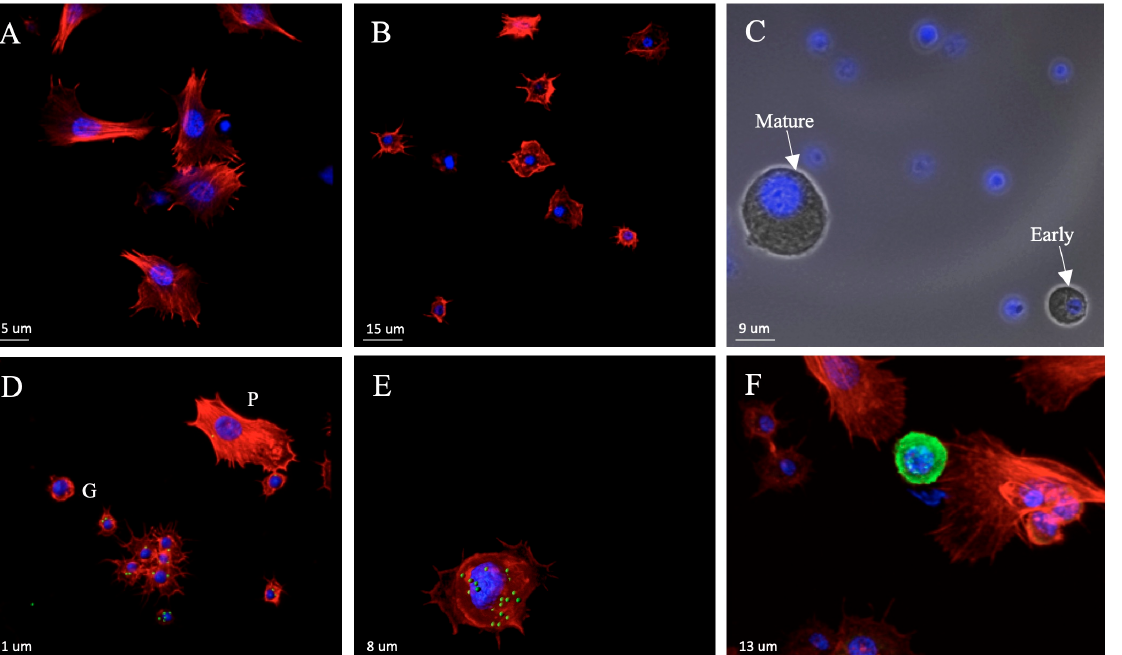
Figure 3. The overall cell composition of the total number of hemocytes during the phagocytosis assay as measured via imaging ( N = 44 larvae). The most abundant cell types are granulocytes, followed by plasmatocytes and oenocytoids (panels a , b , and c respectively). Populations were only different for plasmatocye proportions, while only males from Sweden had a significantly higher proportion of oenocytoids. Within each bar plot, colored boxes contain X of the data, with whiskers representing the largest and smallest values within 1.5* interquartile range. The bar with asterisks (*: P ≤ 0.05; **: P ≤ 0.01; ***: P ≤ 0.001) in panel b represents a significant difference be- tween populations, while the letters above each bar plot in panel C denote significance relation- ships among these four samples of oenocytoids. 3.2. Phagocytic Index We then investigated the number of phagocytes (i.e., cells that engulfed bacteria) be- tween the populations, using our phagocytic assay (slide assay), and found that they dif-